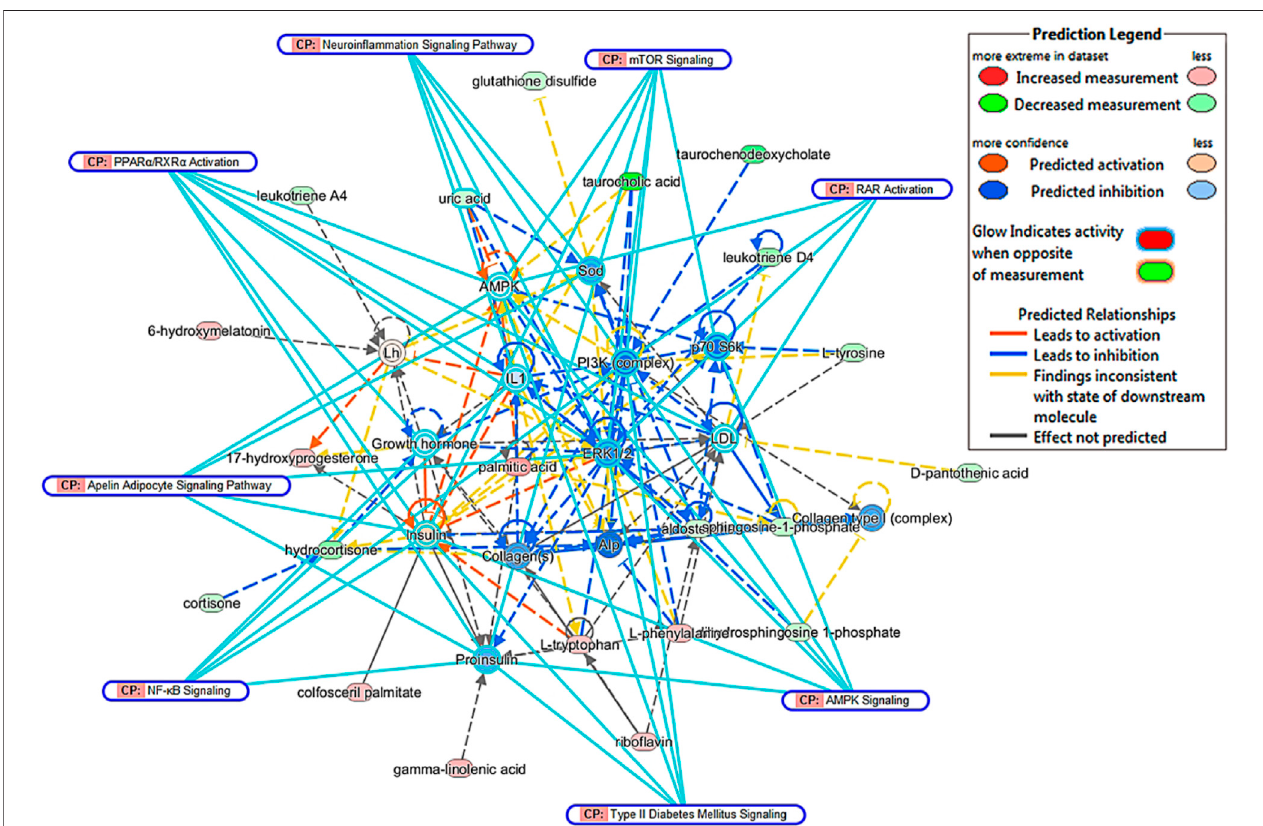
FIGURE 6 | Comprehensive network of blood biomarkers of KLX regulating DR based on the IPA omics platform. Red ellipse indicates increase in metabolite intensity regulated by KLX. Green ellipse indicates decrease in metabolite intensity regulated by KLX. Yellow ellipse indicates molecules activated. Blue ellipse indicates molecules inhibited. Yellow line represents the activation relationship. Blue line represents inhibition relationship. Continuous line represents direct relationships. Dotted line represents indirect relationships. KLX, keluoxin; DR, diabetic retinopathy; IPA, Ingenuity Pathway Analysis.